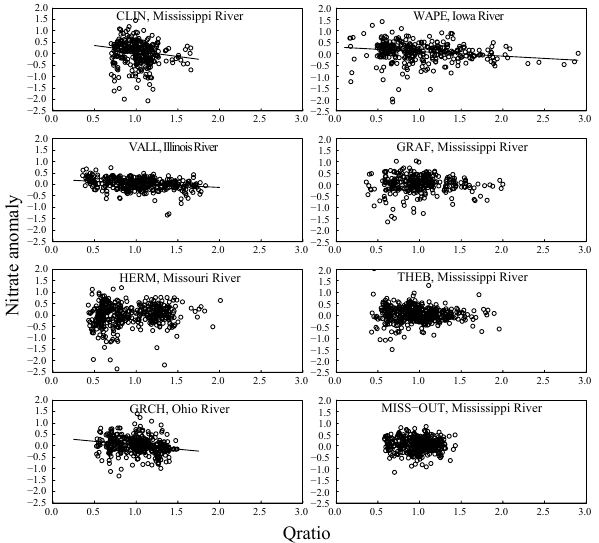
Fig. 3. Plots of nitrate anomaly versus Qratio by site, using all contemporaneous flow data. Statistically significant relationships ( p ≤ 0.05) are denoted with a solid black